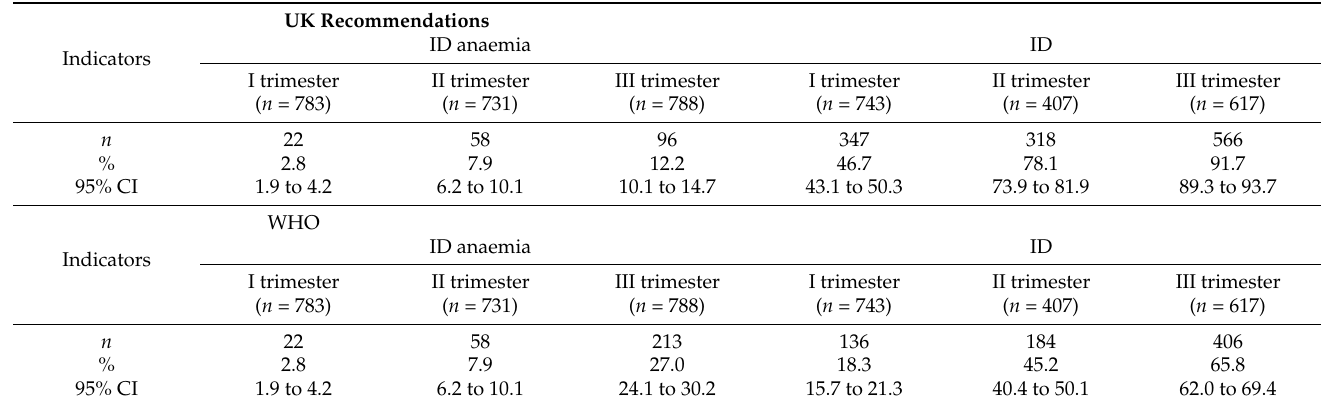
Table 2. ID and ID anaemia data according to WHO and UK